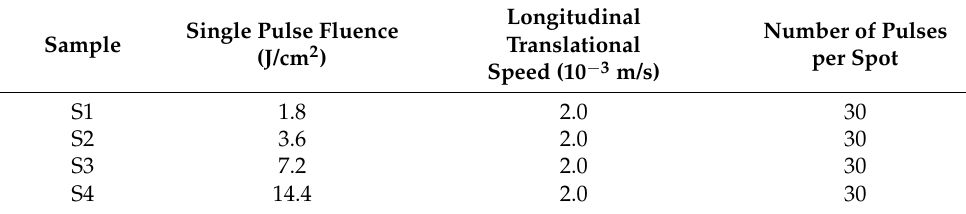
Table 1. Experimental parameters of the four different nanotexturing